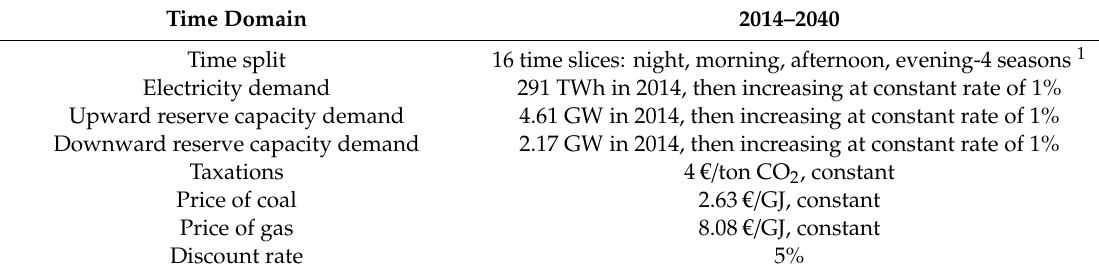
Table 1. Structural and scenario-independent inputs for the case